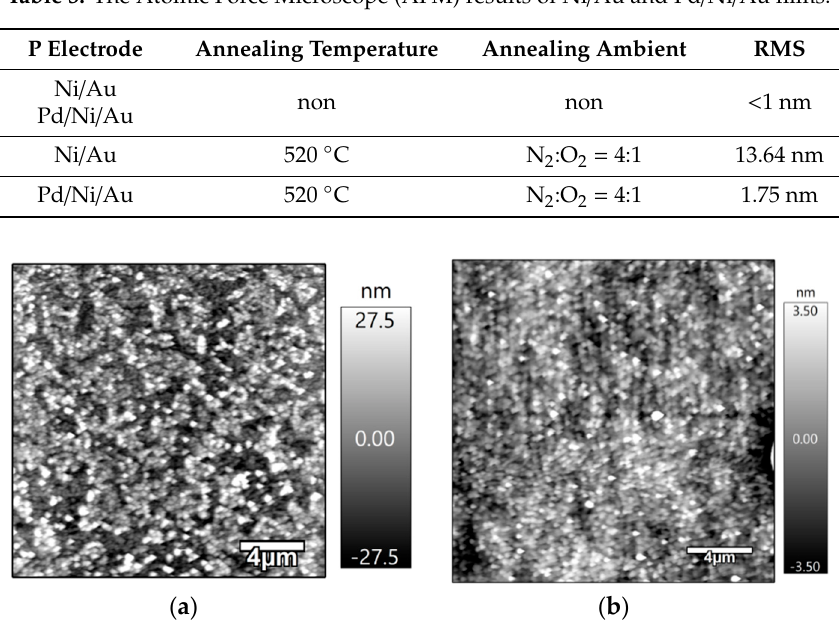
Figure 6. AFM image of ( a ) Ni/Au and ( b ) Pd/Ni/Au thin films contacts on GaN laser diode, after annealing at 520 °C for 5 min in O 2 and N 2 ambient.